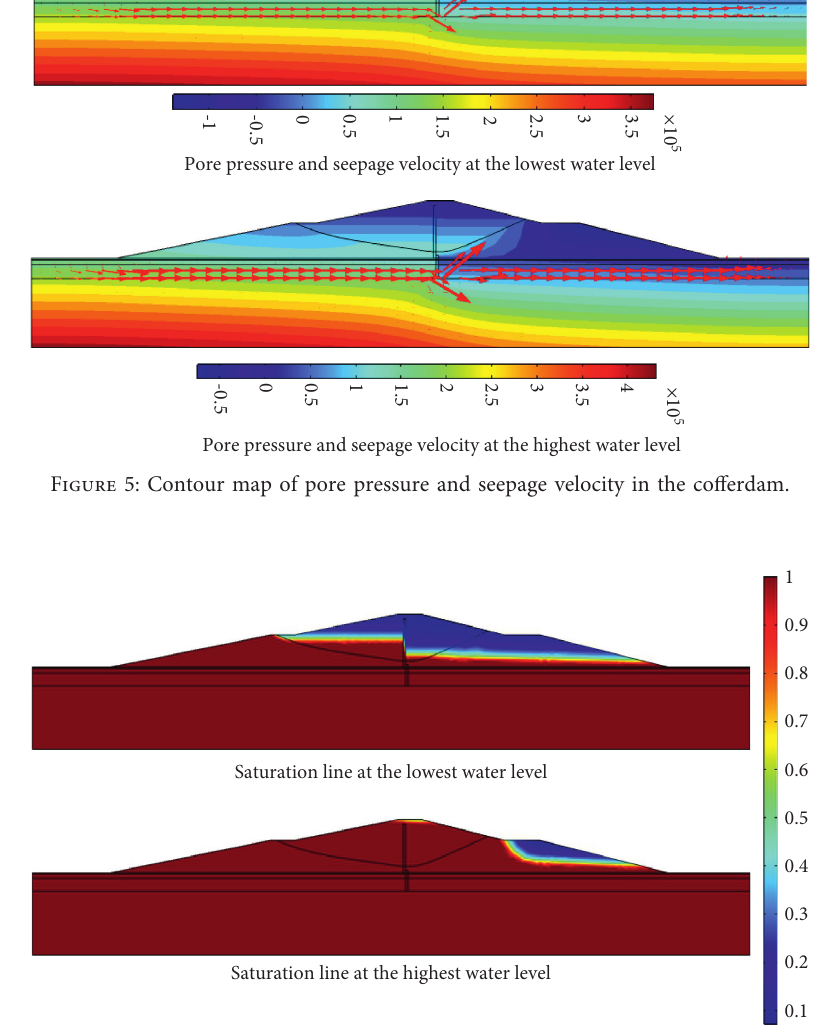
Figure 6: Contour map of the seepage line in the cofferdam.